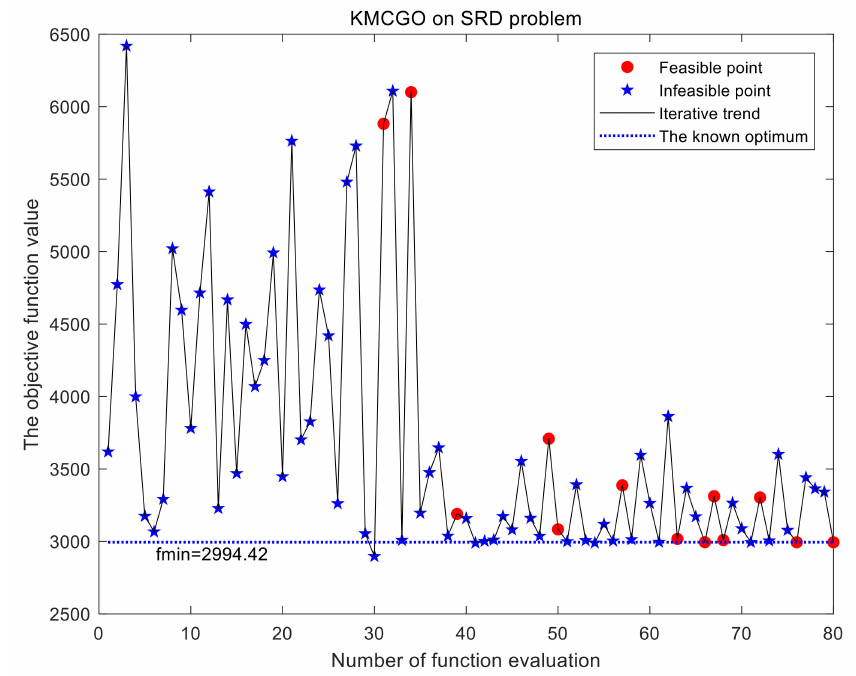
Figure 11. Iteration result of the SRD